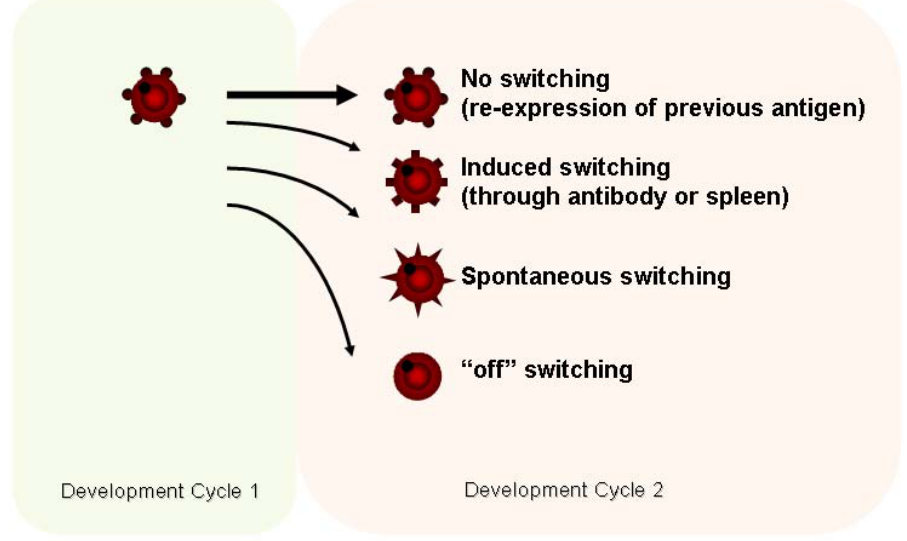
Figure 8. Suggested switching pathways of var -genes and their PfEMP1 in P.falciparum.